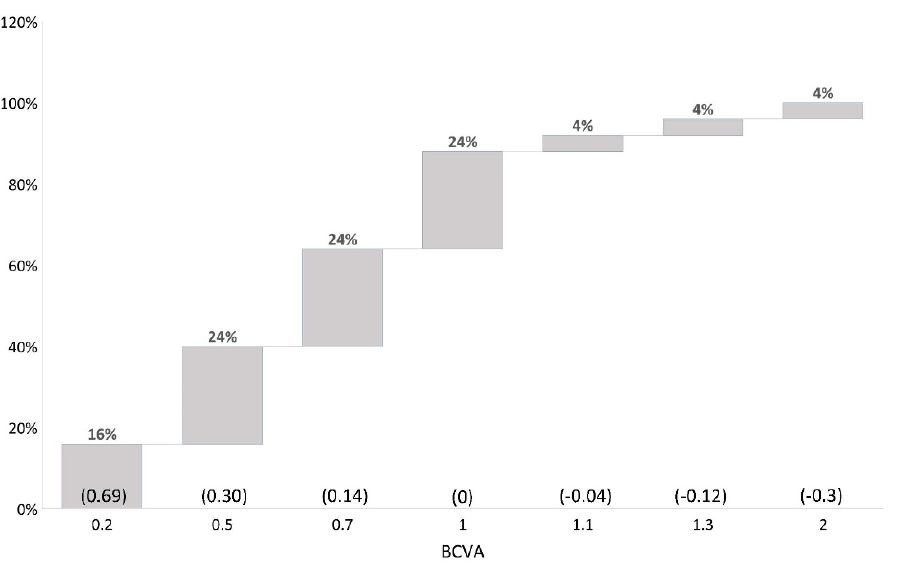
Figure 3. Displaying distribution of best-corrected visual acuity outcome after DMEK “Wave Maneu- ver” operation. LogMAR values in parentheses. BCVA: best corrected visual